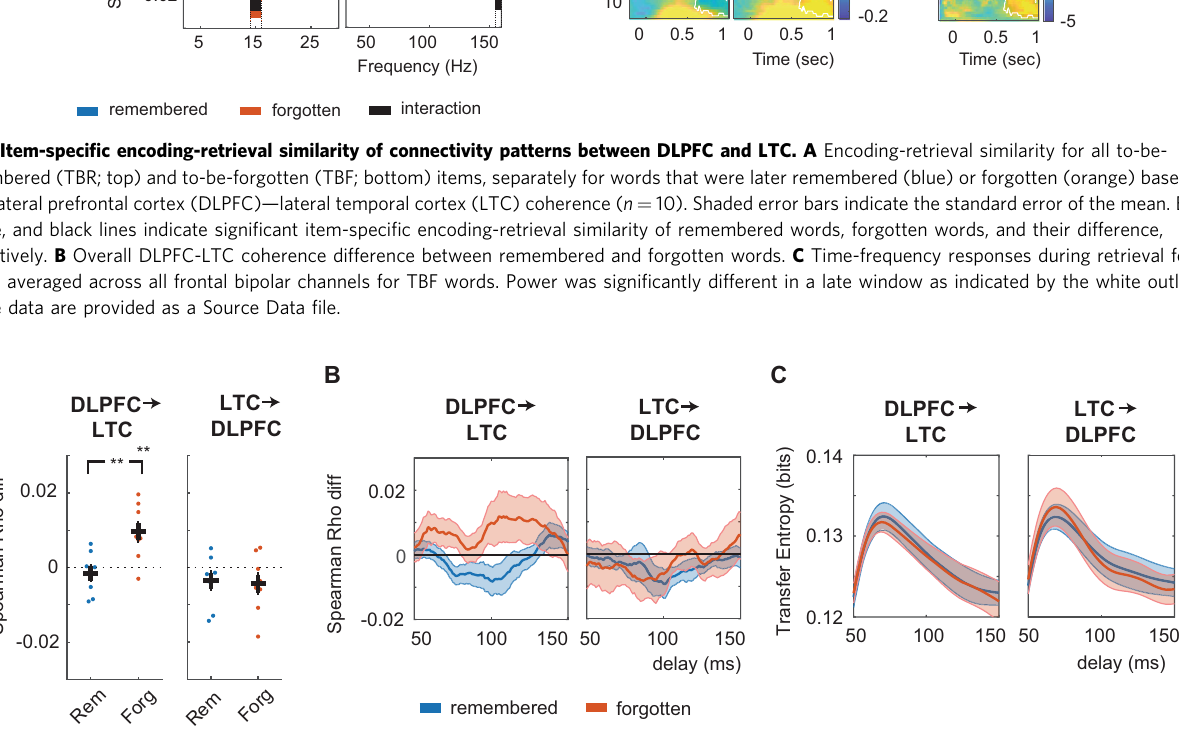
Cue-related effects in DLPFC and LTC . Finally, we evaluated time-frequency patterns in DLPFC and LTC during the time period of the cue presentation in order to investigate their pos- sible relationship to ERS effects. In the LTC, we found a main